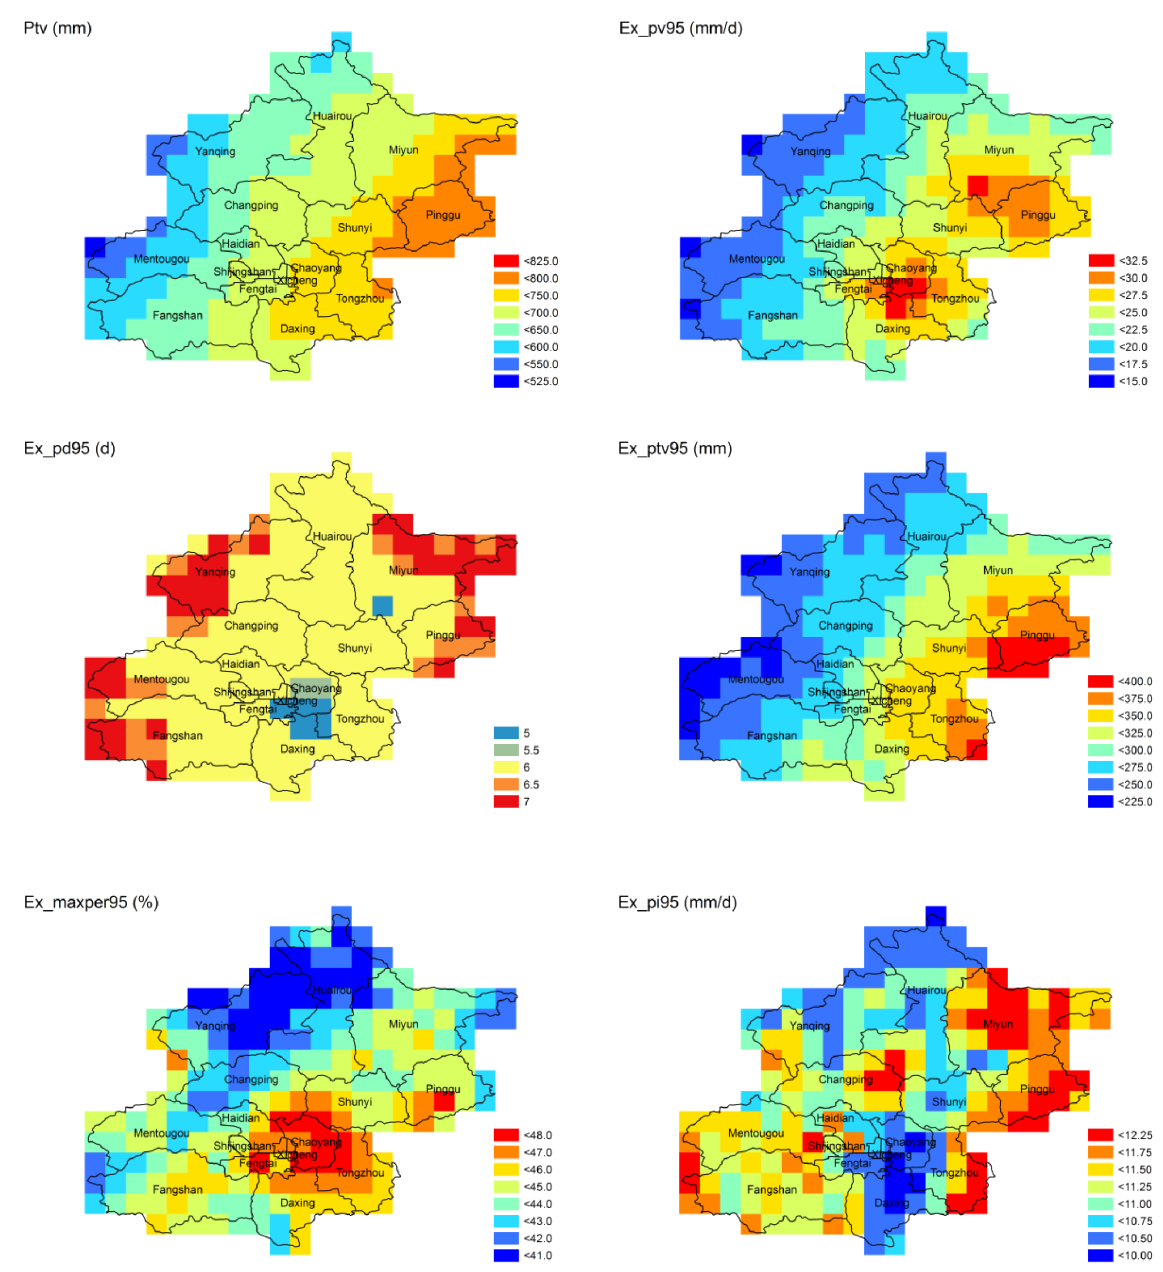
Figure 2. Climatological annual-median values of extreme precipitation based on 3h gridded data during 1979–2012. (From the left to the right and from the up to the bottom, the figures referred to (a) median annual precipitation (PTV); (b) extreme precipitation threshold (Ex_pv95); (c) extreme precipitation days (Ex_pd95); (d) extreme precipitation amount (Ex_ptv95); (e) extreme precipitation proportion (Ex_maxper95); (f) extreme precipitation intensity (Ex_pi95) calculated at upper 95th percentile by Jenkinson’s formula, respectively).